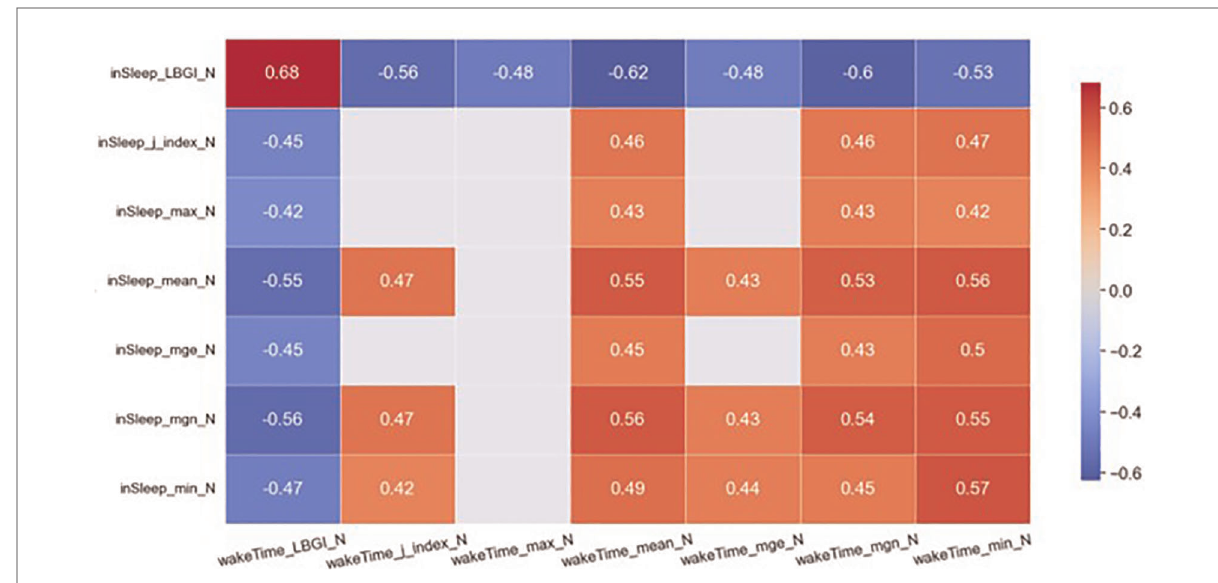
FIGURE 3 Heatmap of signi fi cant correlations between in sleep GV metrics of day N and awake-time GV metrics of day N. Only moderate (0.4< rmcor ≤ 0.6) to strong correlations ( rmcor >0.6) are shown.